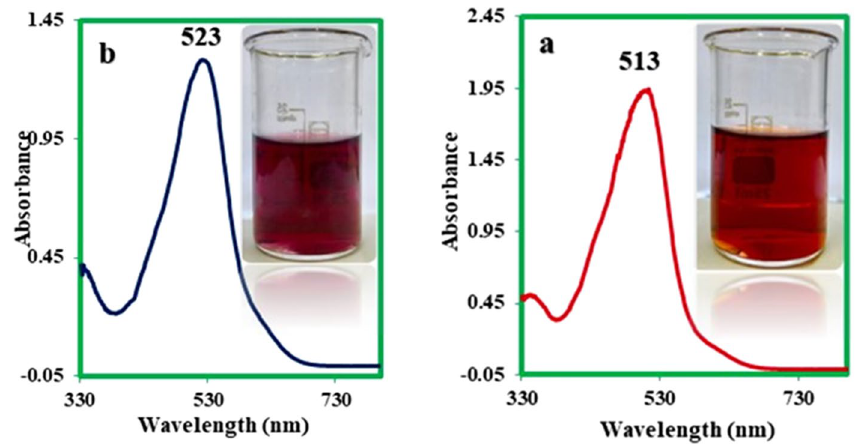
Figure 23. Ultraviolet / Visible absorption spectra ( a ) 1S-RED and ( b ) 2S-RED solution separately in acetone. Room